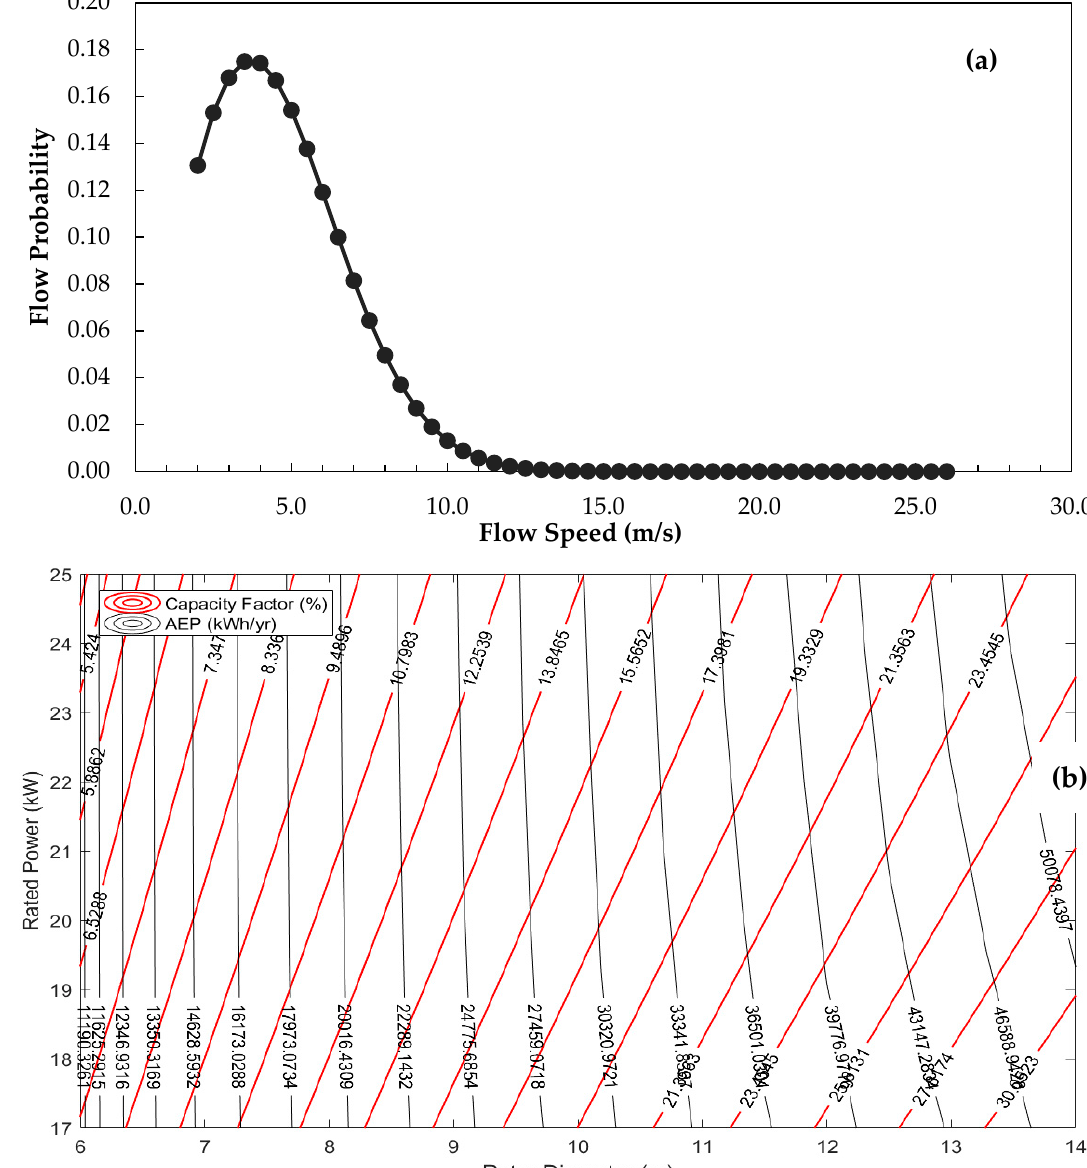
Figure 11. ( a ) Weibull probability density function at the Deniliquin site. ( b ) The AEP for different turbine diameters for Weibull function parameters: k = 2.096 and c = 5.042 m/s.